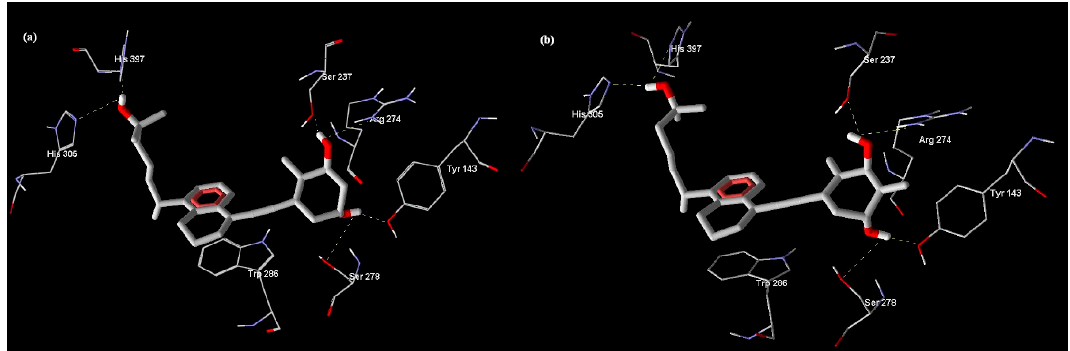
Figure 2. View of the three-dimensional structure of ligand binding cavity of the human vitamin D receptor (hVDR) with the docked (Molegro Virtual Docker) compounds 5 ( a ) and 6 ( b ). The six amino acids (Tyr 143, Ser 237, Arg 274, Ser 278, His 305 and His 397) forming hydrogen bonds with the ligand are depicted. The aromatic D ring of the ligands is parallel to the tryptophan molecule (Trp 286).